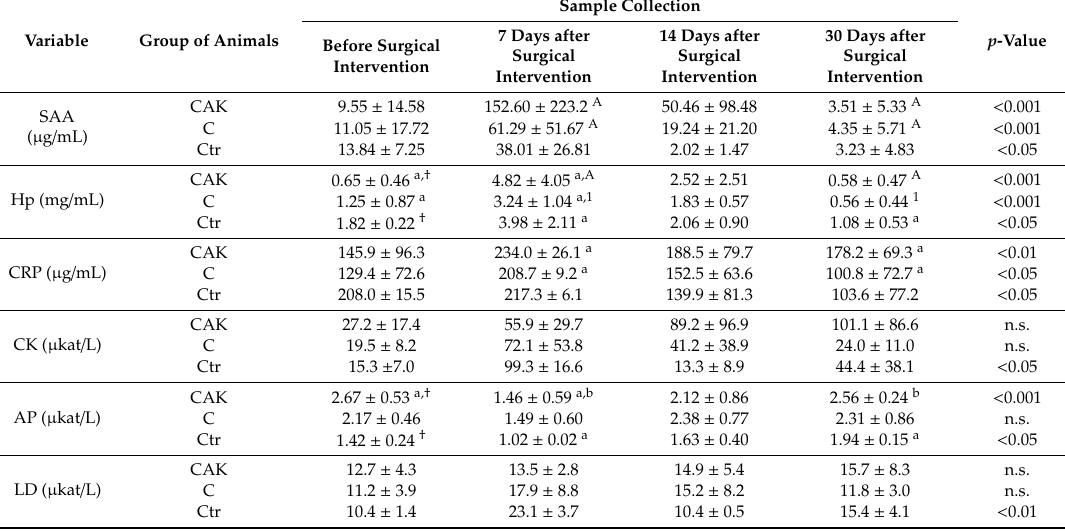
p —significance of the Friedman test. The same superscripts in rows mean statistically significant di ff erences between the sample collections (Dunn test, a,b: p < 0.05, A: p < 0.01, 1: p < 0.001), the superscripts in the same columns mean statistically significant di ff erences between the groups ( † : p <